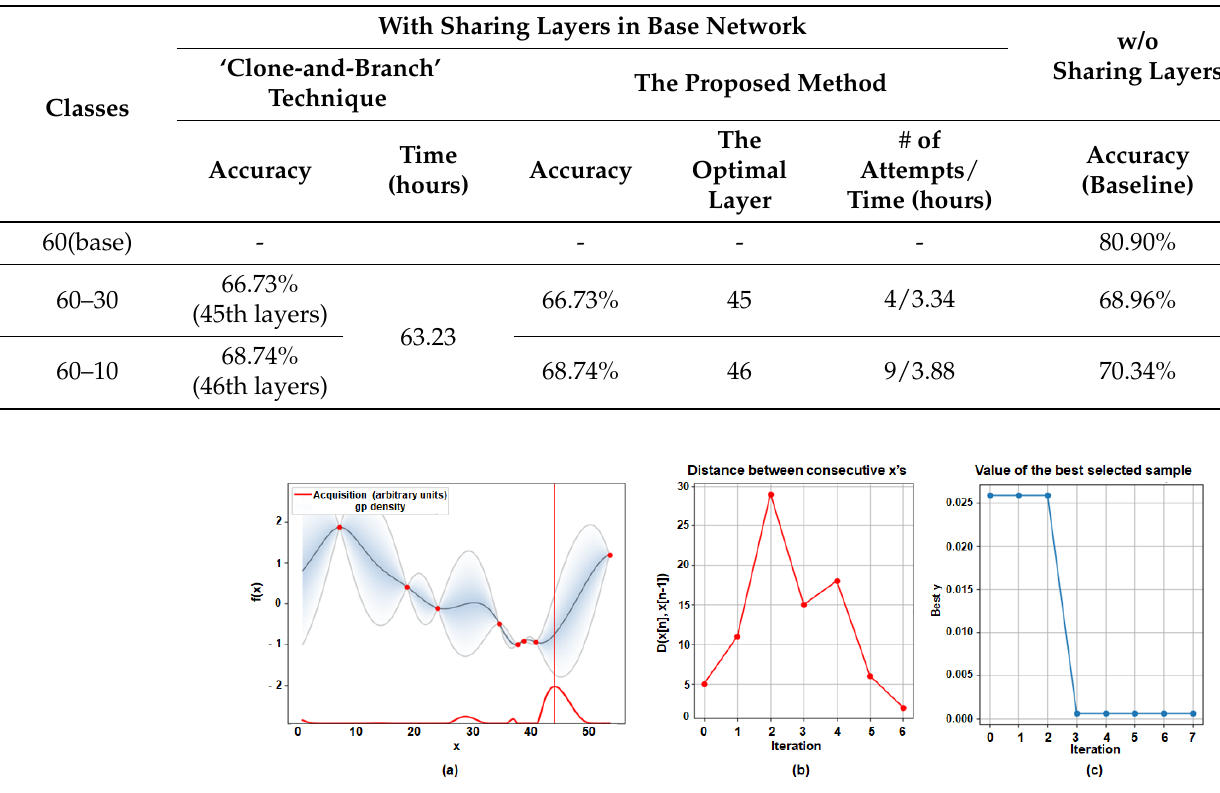
Table 2. Comparison of experimental results for ‘clone and branch’.